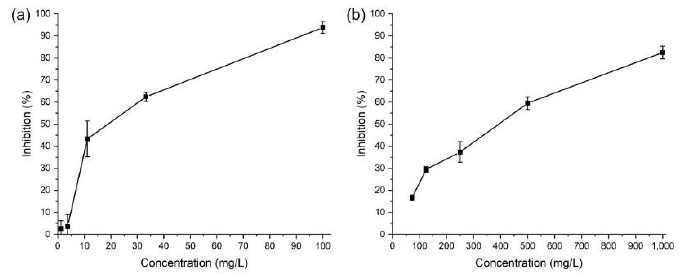
Figure 5. Growth inhibition of ( a ) SWCNTs and ( b ) TiO 2 in 72 h.